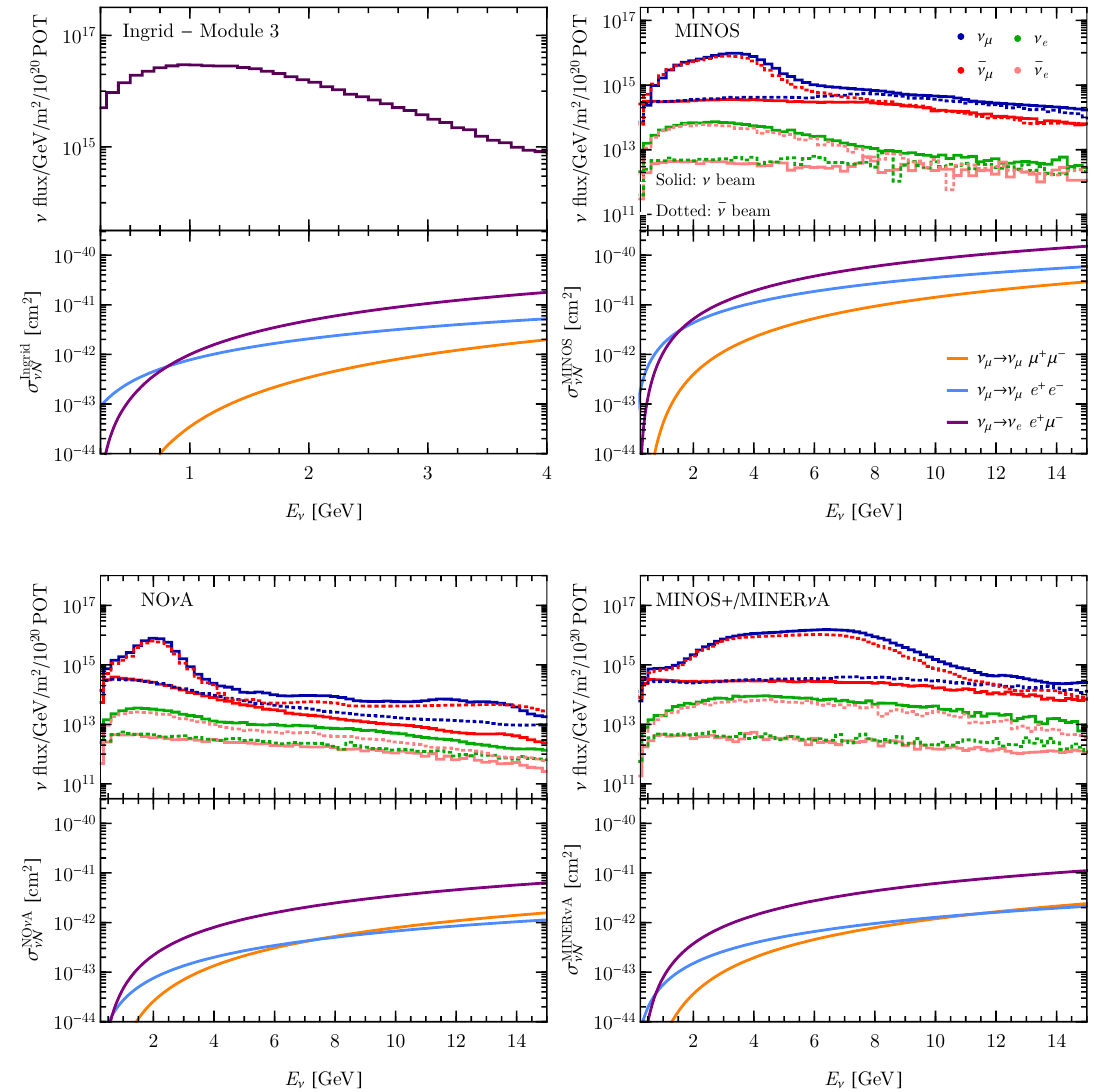
Figure 10 . Energy distribution of the neutrino (cid:13)uxes at the position of the detector (top plot) and corresponding total trident production cross sections (bottom plot) for: INGRID [27] ((cid:12)rst panel), MINOS ND [48] (second panel), NO (cid:23) A ND [48] (third panel) and MINER (cid:23) A [48] (fourth panel). The cross sections show here for the composite detectors are normalized by the total number of